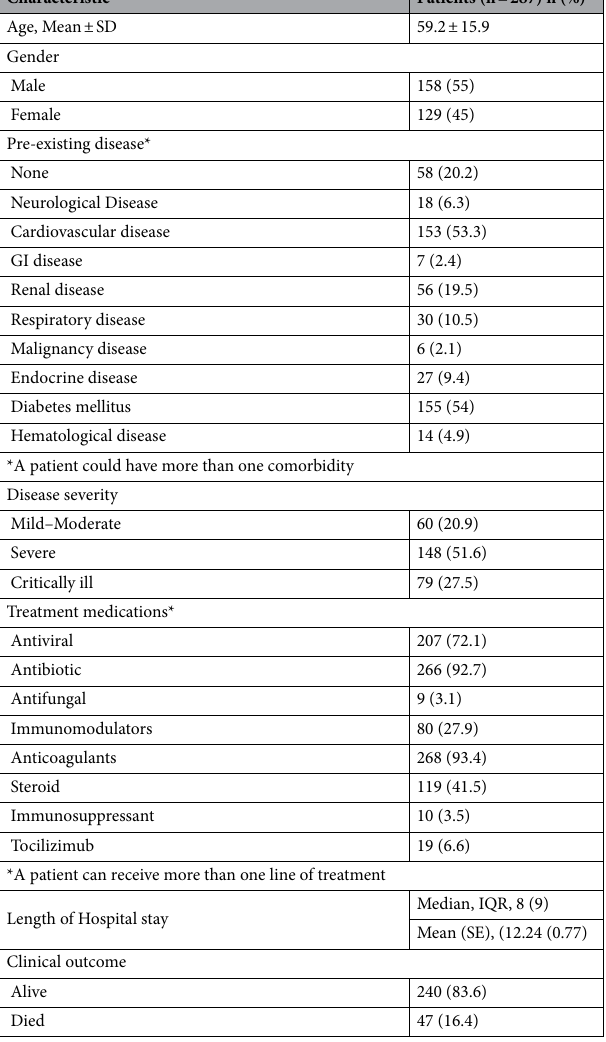
Table 1. Demographic and clinical characteristics of patients.